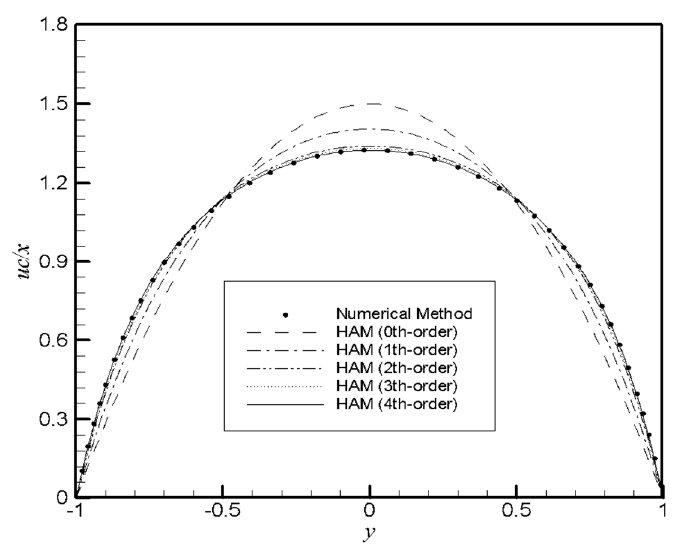
Figure 2. The analytical results for uc / x obtained by the DTM at different orders of approximation compared with the numerical results Re = 5 and α = − 1.